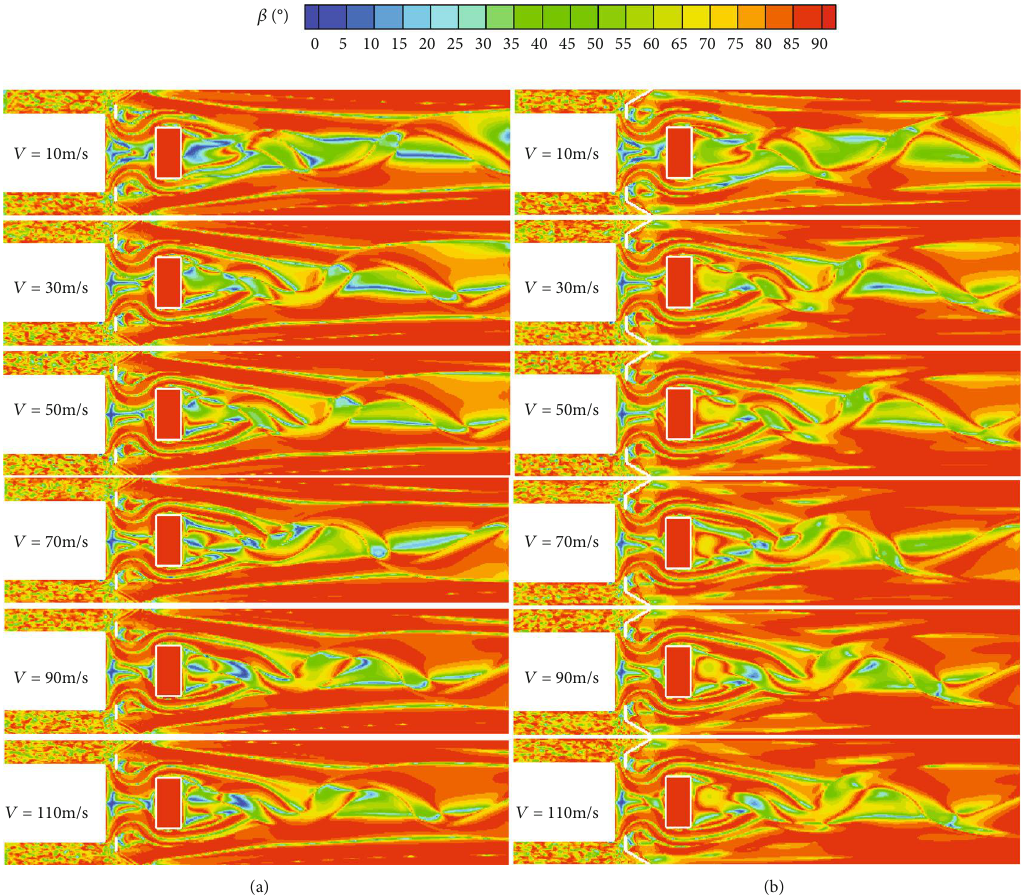
Figure 26: Synergy angle distribution under di ff erent inlet